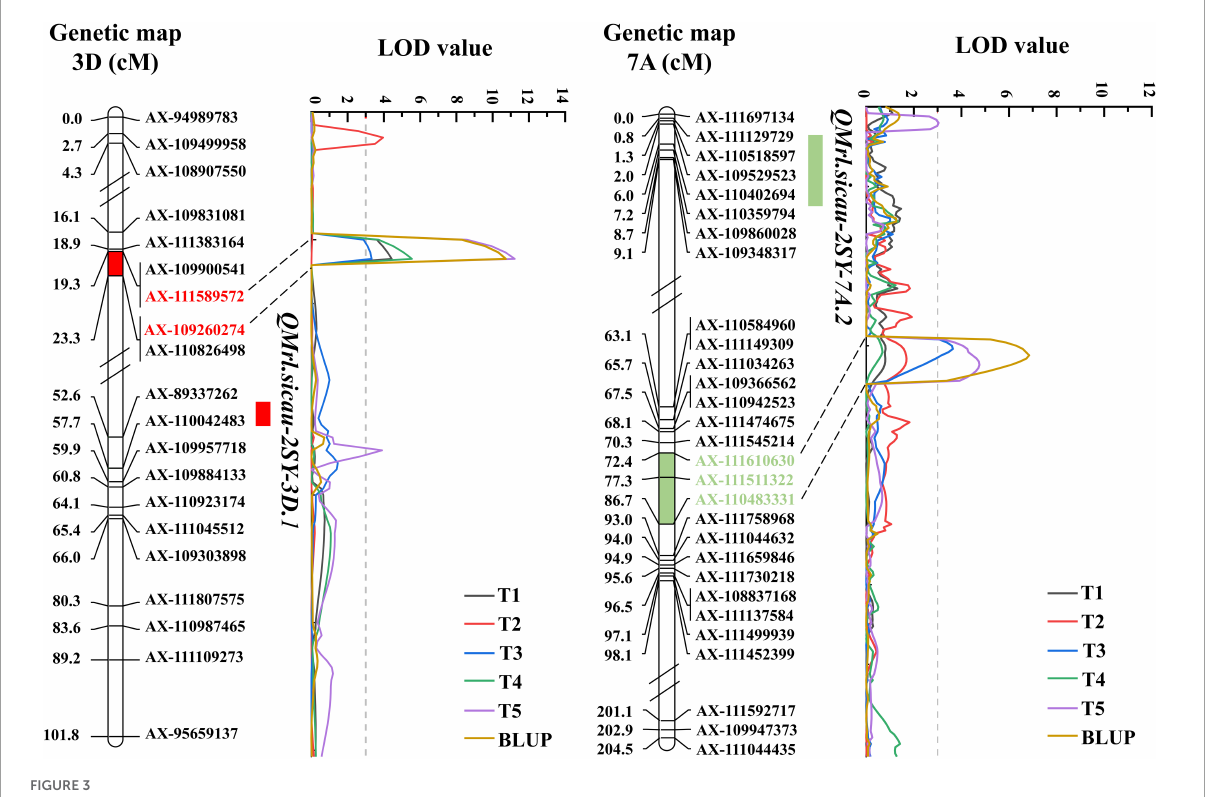
FIGURE3 Genetic maps of the major quantitative trait loci (QTL).